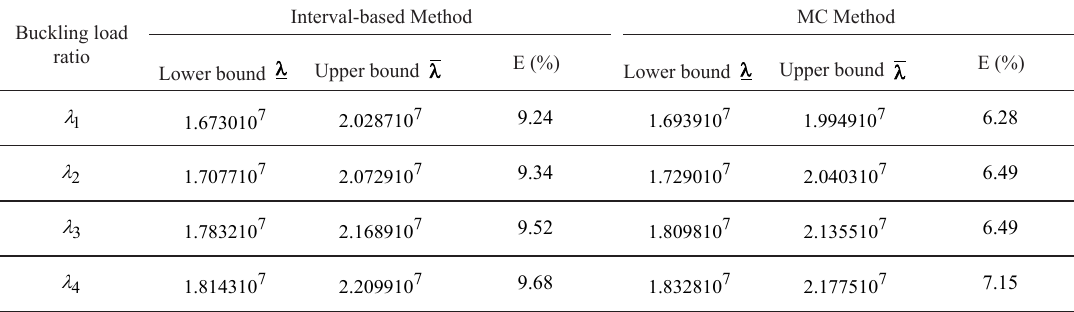
Table 2. Error-values for interval output variables obtained by the Interval-based Method and the MC method. Buckling load ratio